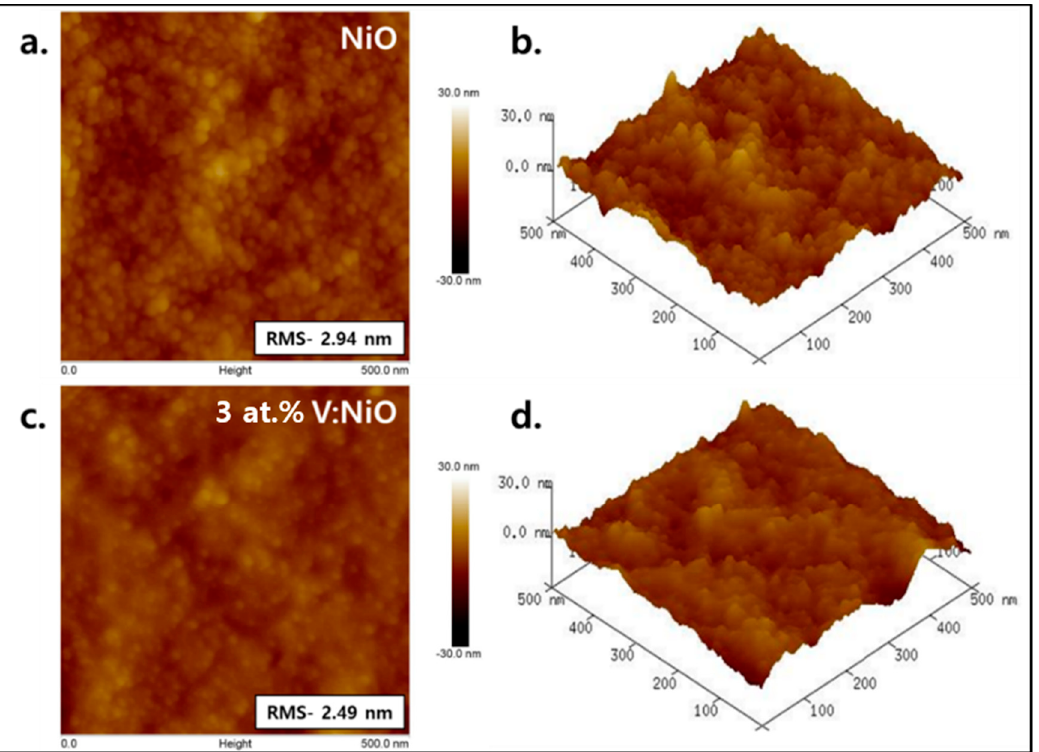
Figure 6. AFM topography and 3D AFM images of ( a , b ) NiO NPs and ( c , d ) 3 at.%V:NiO.